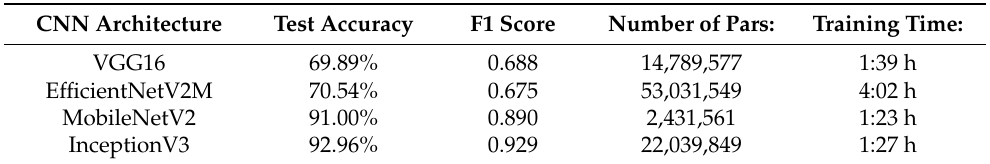
Table 3. Test accuracy and F1 metrics, number of trainable parameters and training time for each architecture.